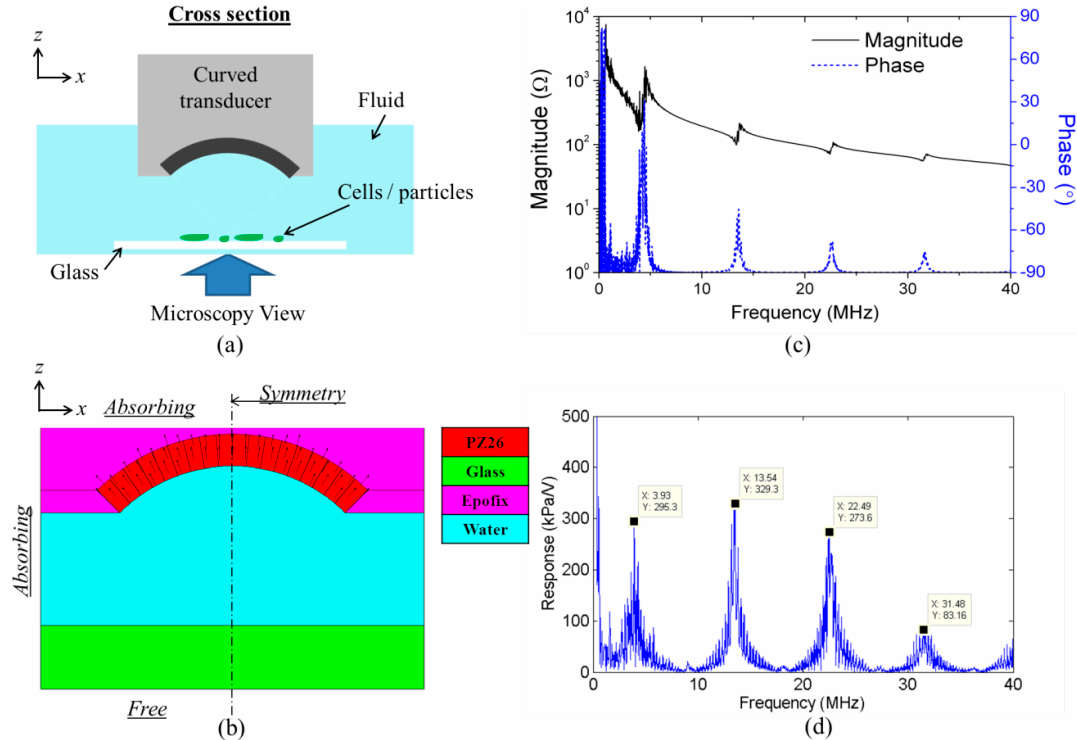
Figure 5. ( a ) Schematic diagram of the curved ultrasonic resonator; ( b ) PZFlex model with assigned materials and boundary conditions; ( c ) impedance spectrum of the resonator; and ( d ) acoustic pressure response spectrum at the focal point of the transducer.